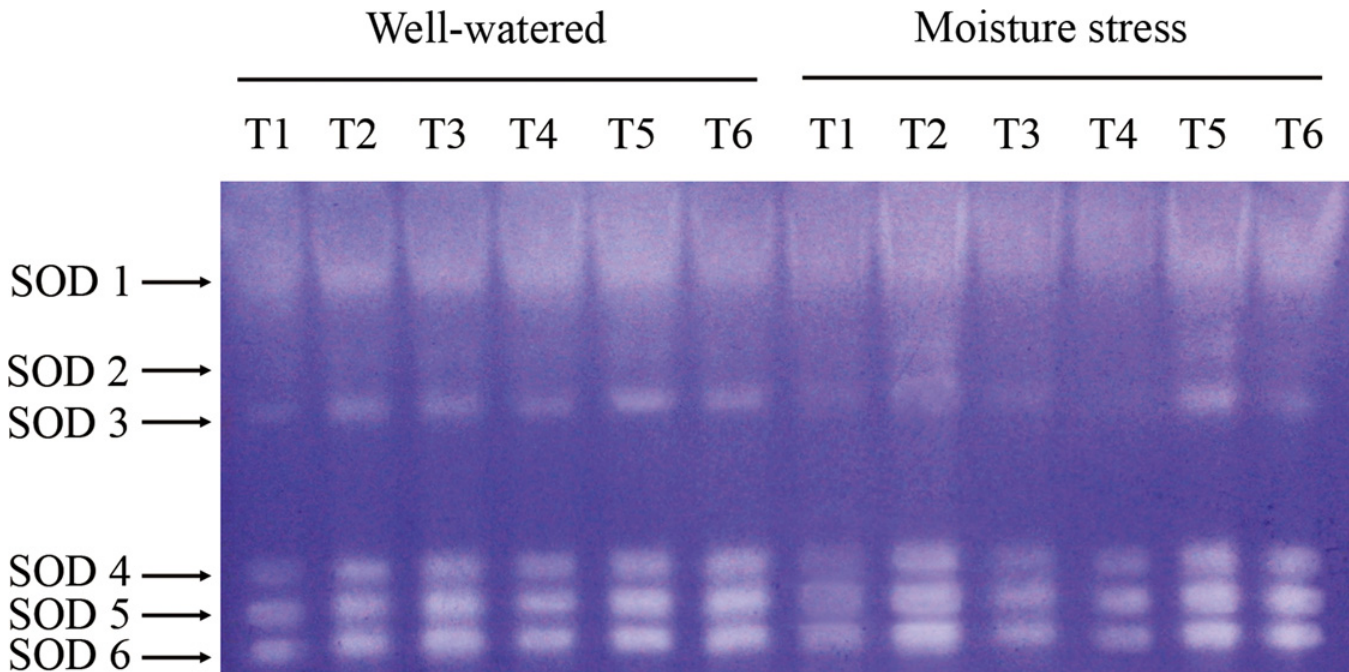
Fig 6. Native gel stained for the activity of SOD isoforms of drought stressed creeping bentgrass treated with cytokinin trans -zeatin riboside (CK) and nitrogen. T1 to T6 represent low N + CK0, low N + CK100, low N + CK10, high N + CK0, high N + CK100, high N + CK10 of creeping bentgrass at 40 d,